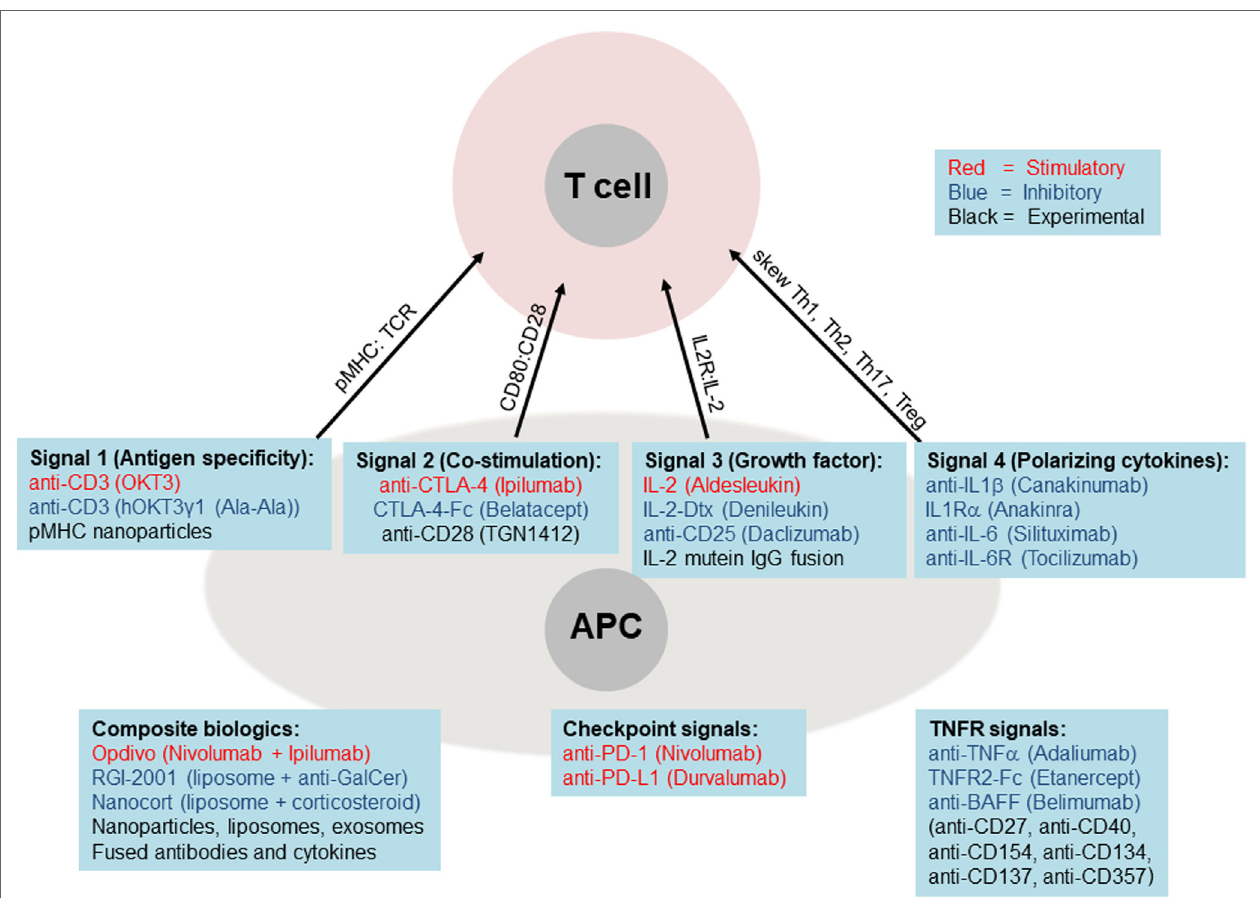
FigURe 4 | Biologics targeting core immune pathways. Current (FDA-approved) biologic medications are shown as stimulatory (red font), inhibitory (blue font), or experimental (black font). These biologics are listed below each of the main four pathways, plus the critical TNF receptor and checkpoint pathways. The lower left panel lists examples of composite biologics composed of two or more biologics and